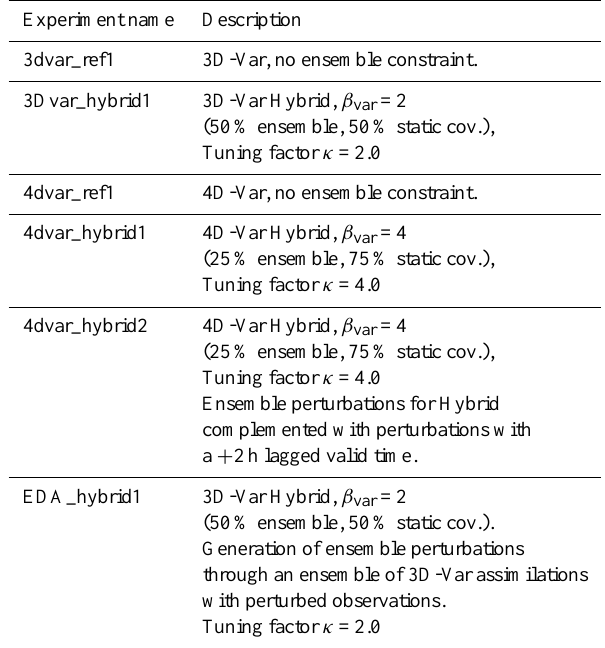
Table 2. Description of experiments carried out with the HIRLAM Hybrid variational ensemble data assimilation for the winter